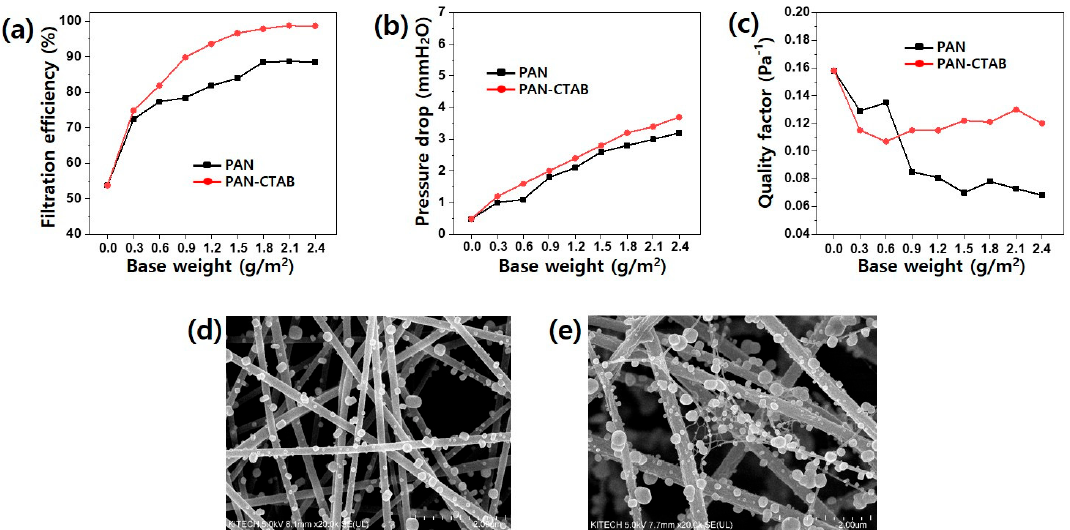
Figure 5. ( a ) Filtration efficiency, ( b ) pressure drop, and ( c ) quality factor of the PAN and PAN–CTAB filter media for different base weights of the electrospun web. The SEM images of ( d ) PAN nanofiber and ( e ) PAN–CTAB filter media after five iterations of the TSI8130 filtration evaluation test.